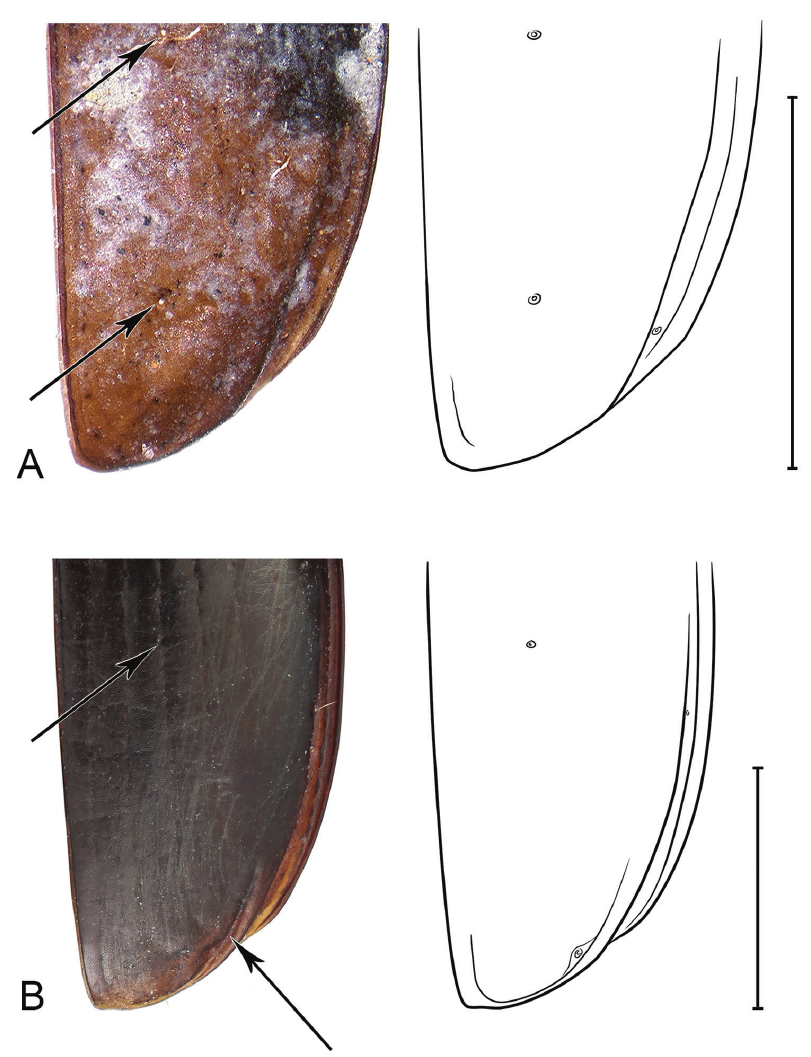
Figure 7. Comparison of the apices of the fossil right elytron A. balli sp. n. and a modern Trechisibus sp. with line drawings of each showing 3 rd interval setigerous pores and recurrent grooves of the latter. An isodiametric microornament is partially visible on the fossil.